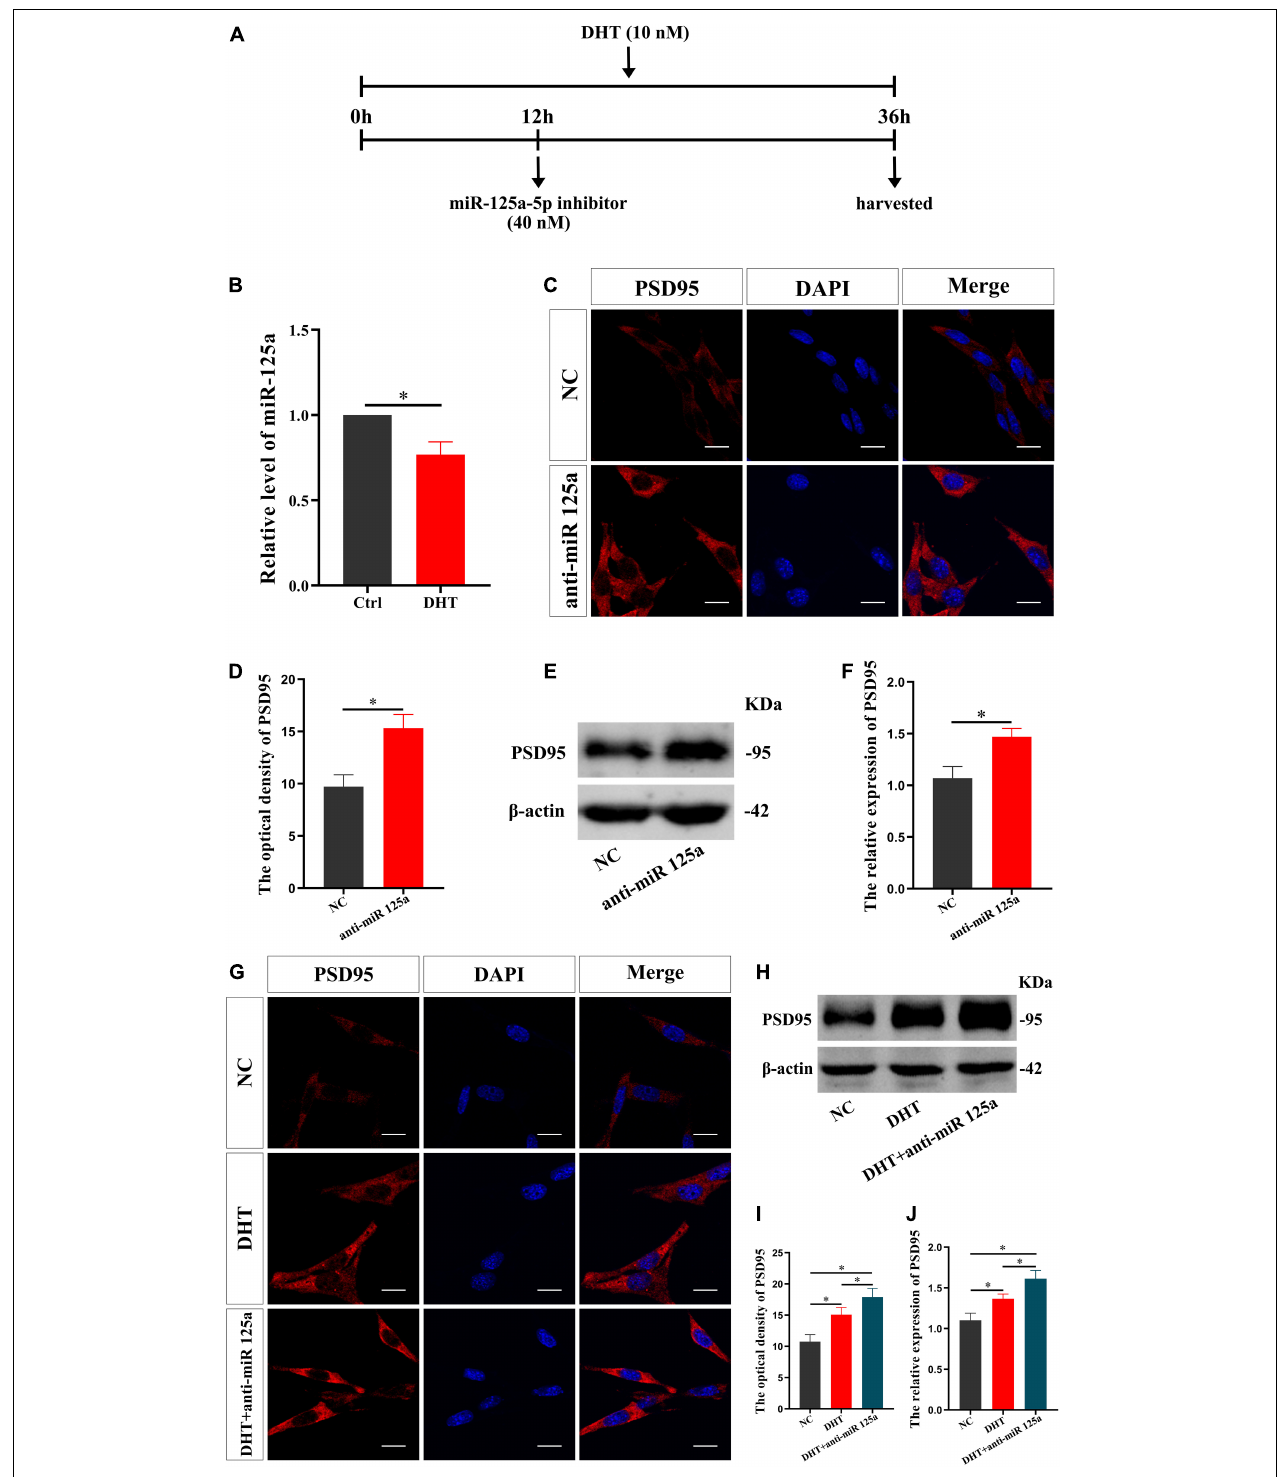
FIGURE 3 | miR-125a regulates DHT affecting the expression of PSD95 protein in HT22 cells. (A) Experimental procedure. HT22 cells were treated with DHT (10 nM) and miR-125a-5p inhibitor (40 nM). (B) qRT-PCR for miR-125a induced by DHT in HT22 cells. (C , D) Immunofluorescence cytochemistry for PSD95 expression in HT22 cells pre-treated with NC inhibitor or miR-125a-5p inhibitor. (E,F) Western blotting for PSD95 expression in HT22 cells pre-treated with NC or miR-125a-5p inhibitors. (G , I) Immunofluorescence cytochemistry for PSD95 expression induced by DHT via miR-125a in HT22 cells. (H,J) Western blotting for PSD95 expression induced by DHT via miR-125a in HT22 cells. Scale bars = 20 µ m (* p < 0.05, n = 5).